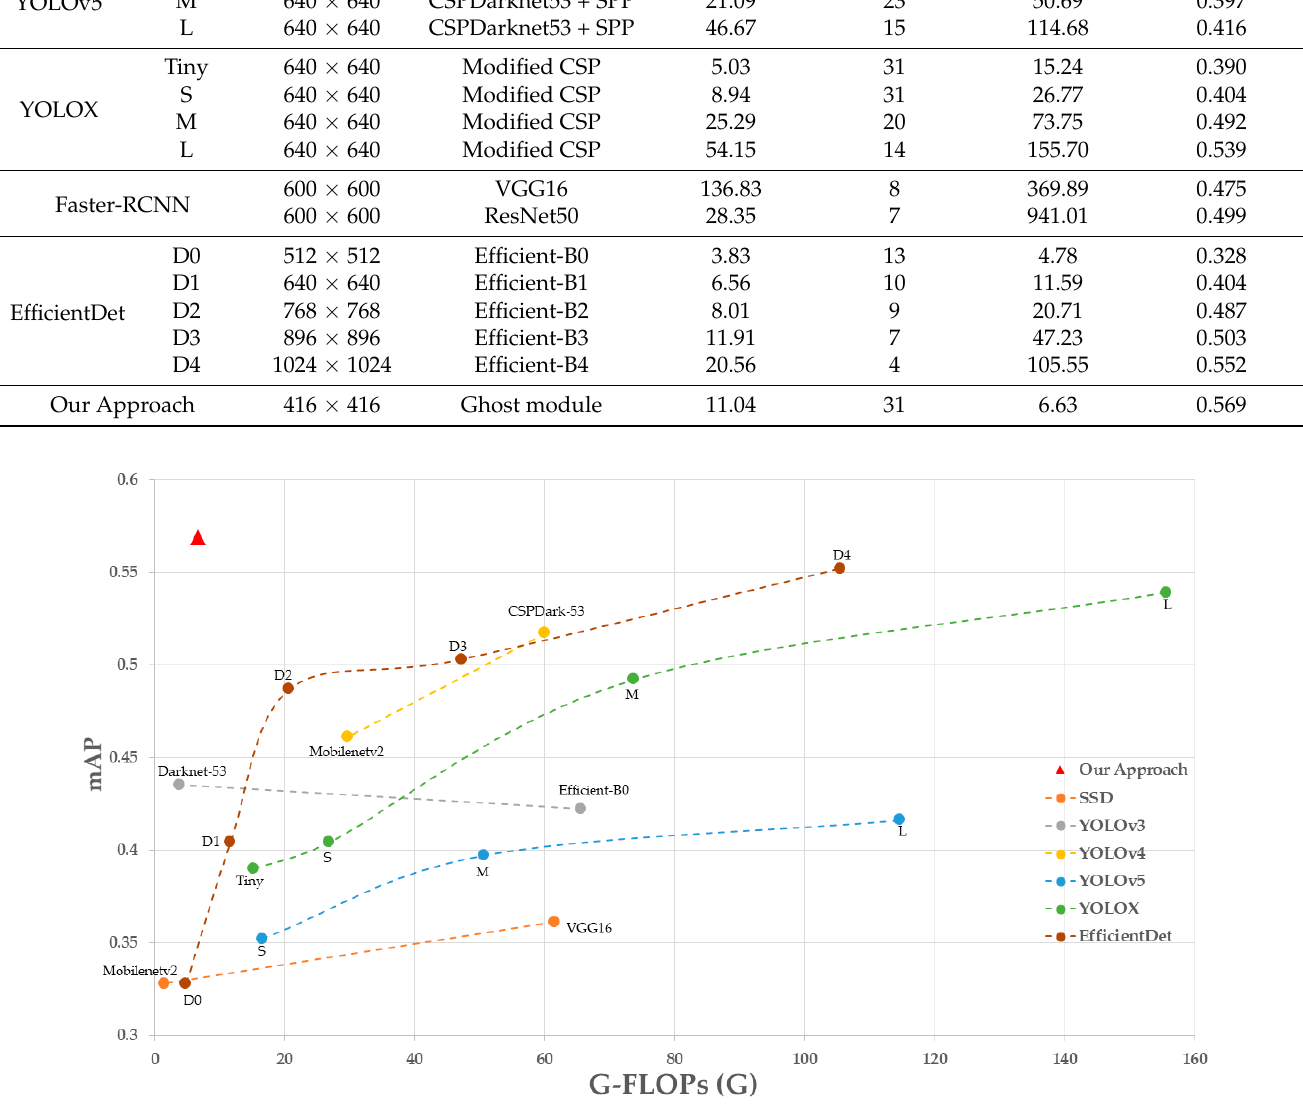
Figure 12. G-FLOPs(G) vs. mAP. Details are in Table 11. Note that our approach obtains higher accuracy while having less model complexity.